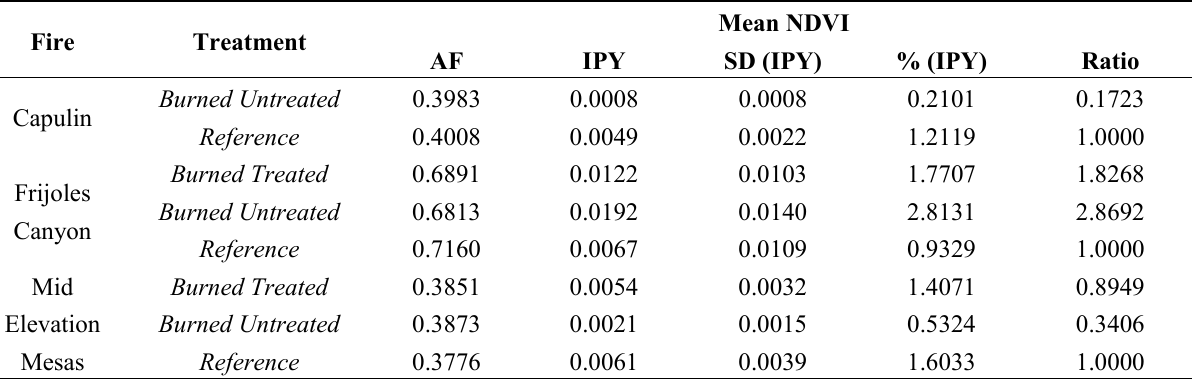
Table 2. Statistics for the mean monsoon NDVI trend estimated from the MODIS NDVI time series data. Where AF is the mean NDVI monsoon reading the first year after fire, IPY is the increment per year in NDVI units after the first year reading, percent is related to the increment based on the AF and Ratio results from the division between the treatment and the reference areas AF per